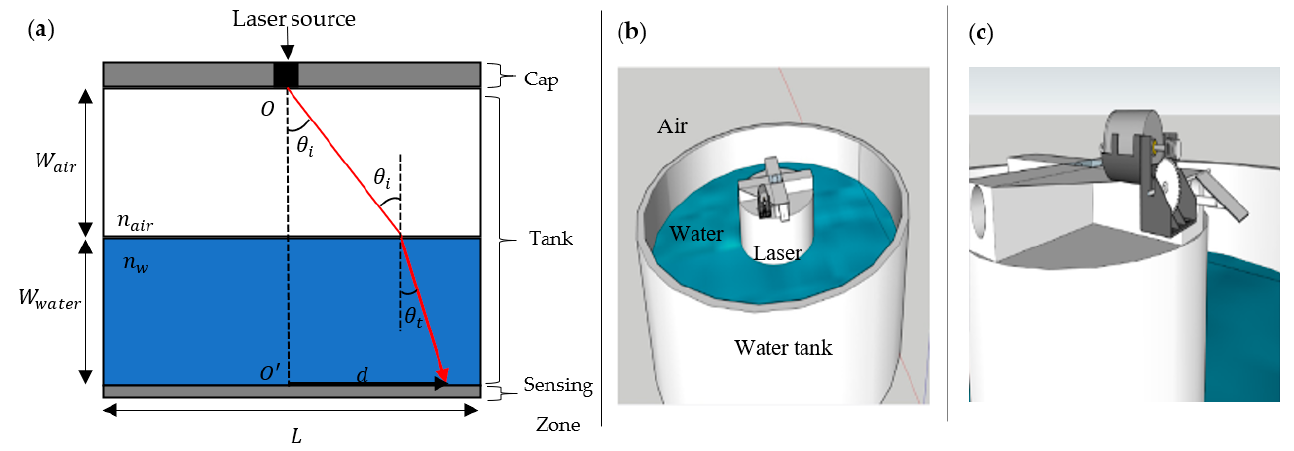
Figure 1. ( a ) Sensor concept and design; ( b ) design top view; ( c ) laser source side view. The light with an angle of incidence θ i is emitted from the point of incidence O from the laser in the cap, towards the tank partially filled with the water sample. This incident angle can be controlled by a mirror-servo motor concept as shown in Figure 1. The light bends at the air-water interface while traveling from air medium (refractive index n air ) to water sample medium (refractive index n w ), making an angle of refraction θ t with the normal to the boundary. The relation between n air , n w , θ i , and θ t is given by the law of refraction or Snell’s law (Equation (1)).